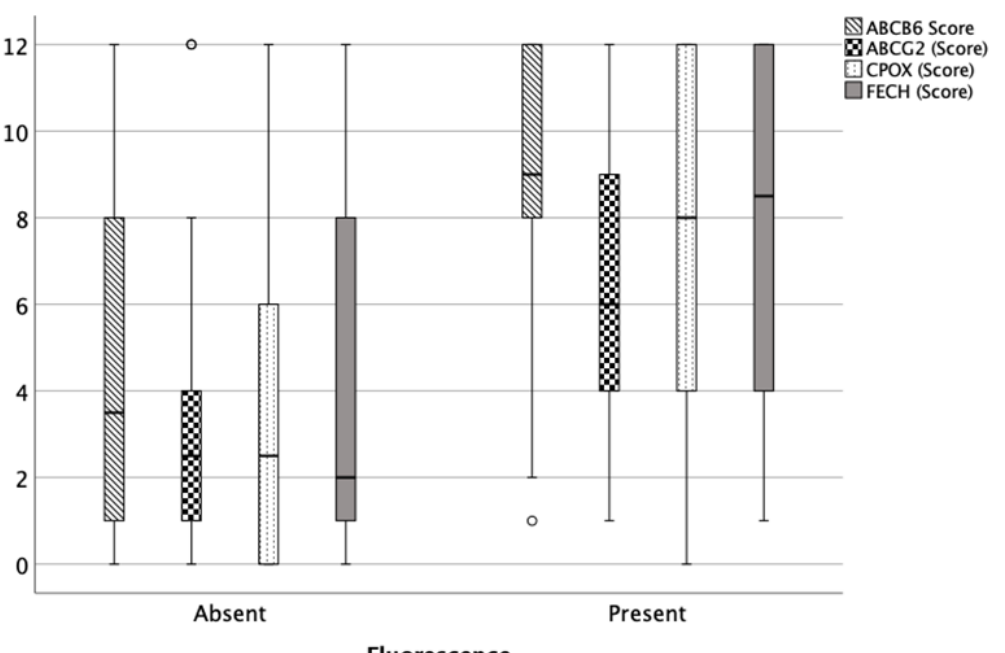
Figure 1. Box-and-whisker plots illustrating ABCB6, ABCG2, FECH and CPOX protein expression correlated with fluorescence, determined with immunohistochemical staining. Median expression scores from immunohistochemistry of all four proteins were significantly higher in fluorescent than in non-fluorescent specimens ( p < 0.001, each). The boxes indicate upper and lower 25% quartiles, the whiskers indicate the minimum and maximum value, the dots indicate the outliers, and the heavy horizontal line indicates the median.